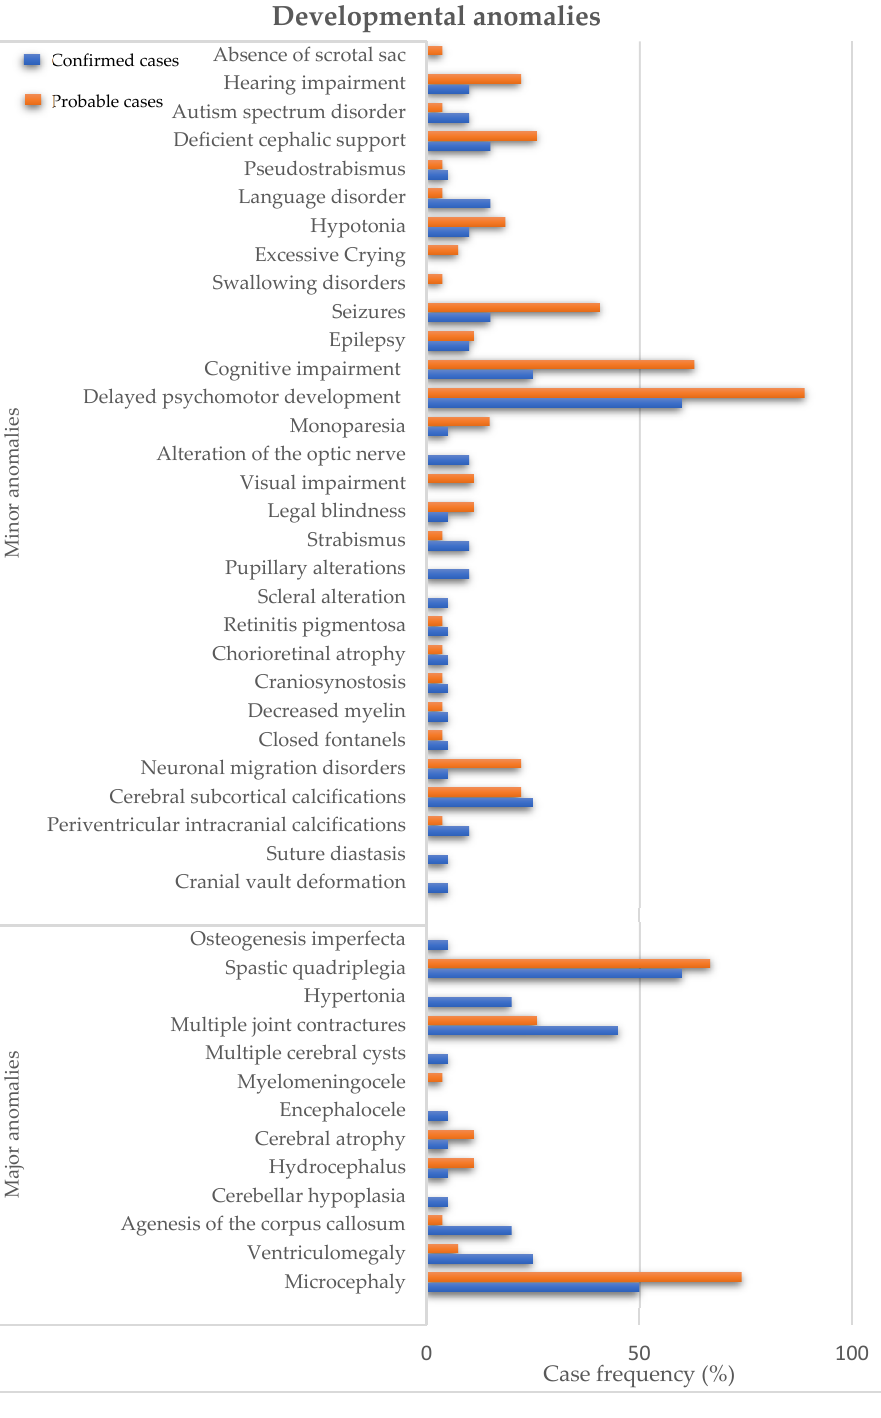
Figure 1. Developmental anomalies in children of mothers infected with ZIKV during pregnancy. Major anomalies are described in confirmed cases (blue bars) and probable cases (orange bars).